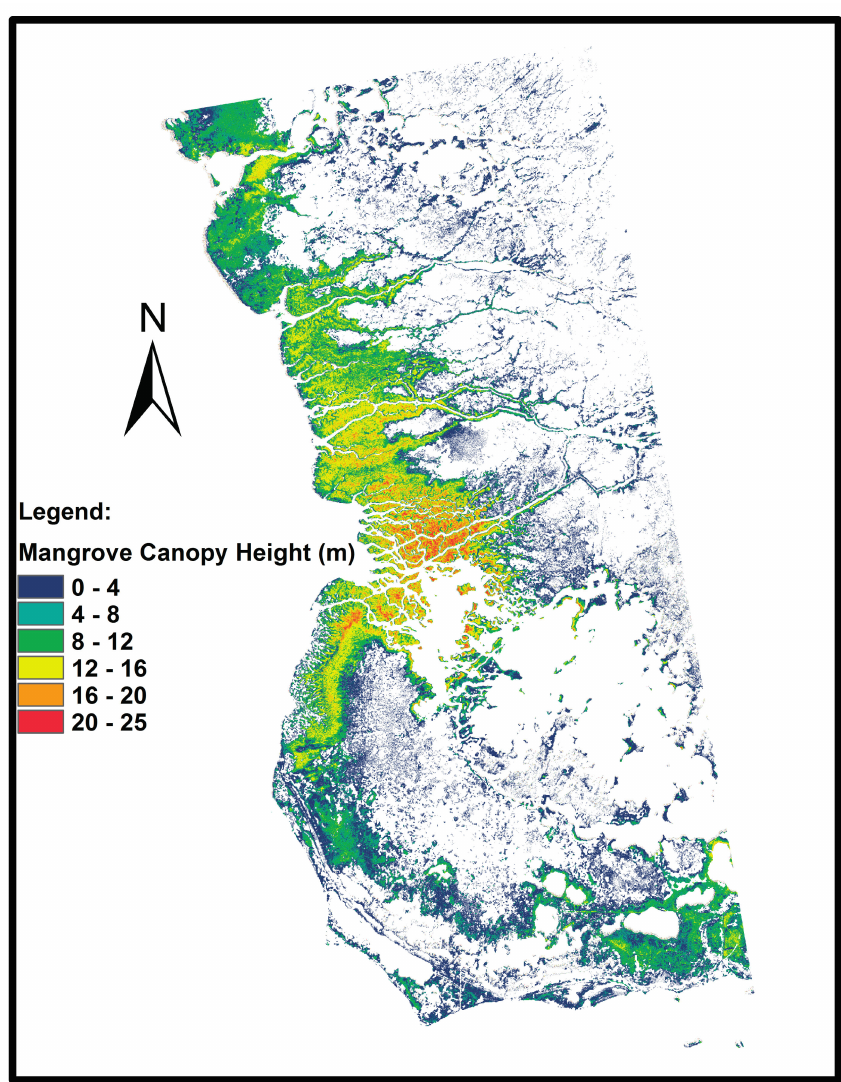
Figure 6. Example of canopy height DCM after TDX Pol-InSAR inversion. This image encompasses one TDX scene on the Western region of the Everglades National